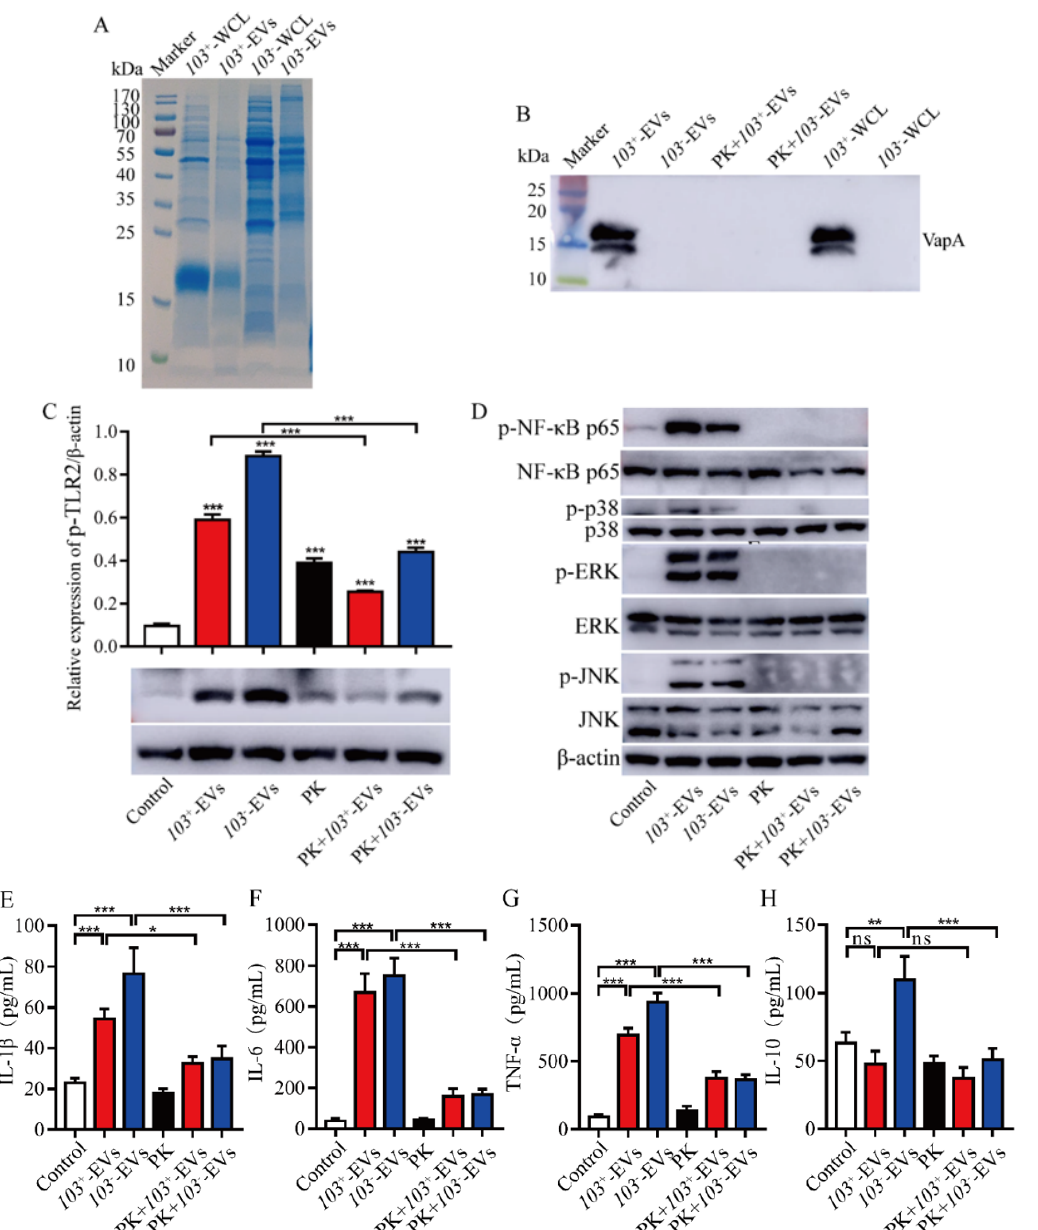
Figure 7. The reduced content of 103 + -EVs and 103 − - EVs proteins decreased the inflammatory effects induced by 103 + -EVs or 103 − - EVs. ( A ) SDS-PAGE analysis of the 103 + -EVs and 103 − - EVs proteins. WCL: whole bacteria cell lyste. ( B ) Western blotting analysis of the exist of virulence associated protein A in 103 + -EVs and 103 − - EVs. PK: proteinase K-treated. ( C , D ) J774A.1 cells were treated with native 103 + -EVs or native 103 − - EVs (5 µ g/mL), proteinase K-treated 103 + -EVs or 103 − - EVs (5 µ g/mL before proteinase K treatment) for different times, respectively, and then detected the ( C ) TLR2 protein, ( D ) phosphorylation of NF- κ B p65, p38, ERK and JNK protein by western blotting. The concentrations of ( E ) IL-1 β , ( F ) IL-6, ( G ) TNF- α , and ( H ) IL-10 in supernatants from J774A.1 cells. J774A.1 cells were treated with native 103 + -EVs or native 103 − -EVs (5 µ g/mL), proteinase K-treated (PK) 103 + -EVs or 103 − -EVs (5 µ g/mL before proteinase K treatment) for 24 h, respectively, and then